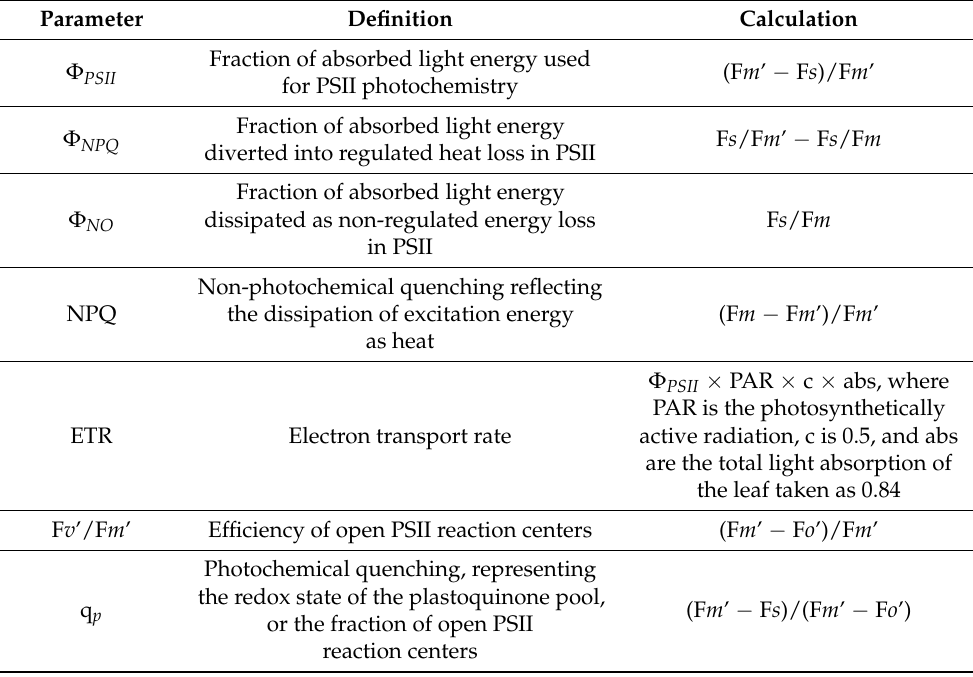
Table 1. Definitions of the chlorophyll fluorescence parameters calculated from the five main chloro- phyll fluorescence parameters (F o , F m , F o ’, F m ’, and F s ).